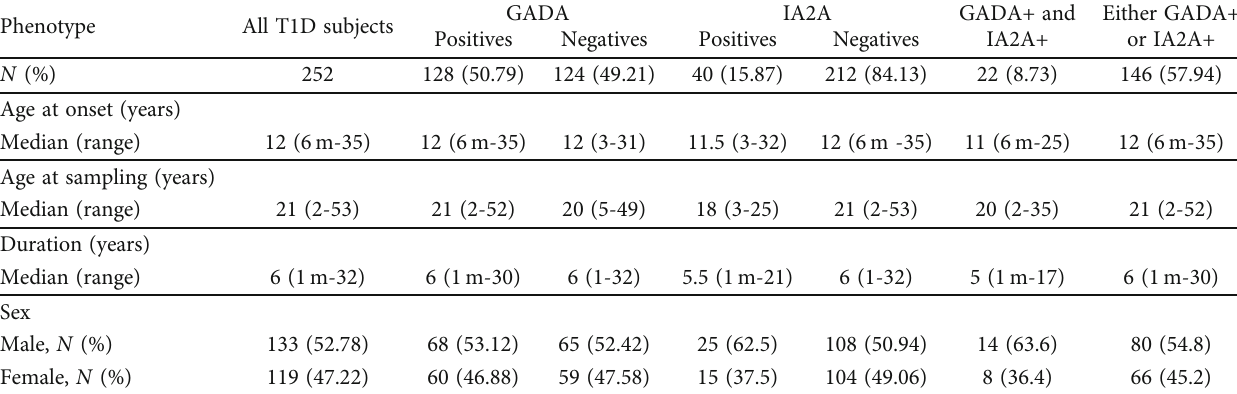
Table 1: Demographic details of 252 type 1 diabetes patients from North